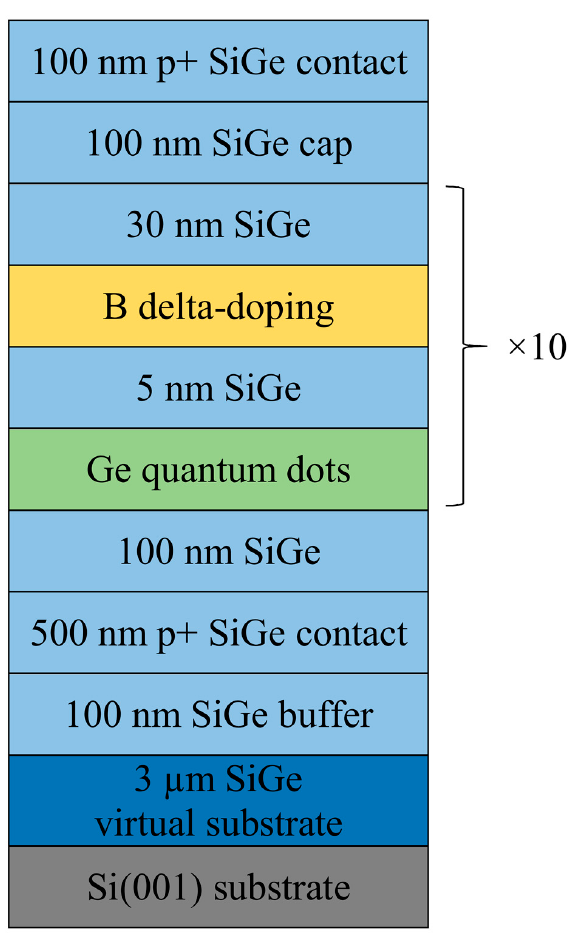
Figure 9. Schematic diagram of the Ge/SiGe photodetector with 10 layers of quantum dots.